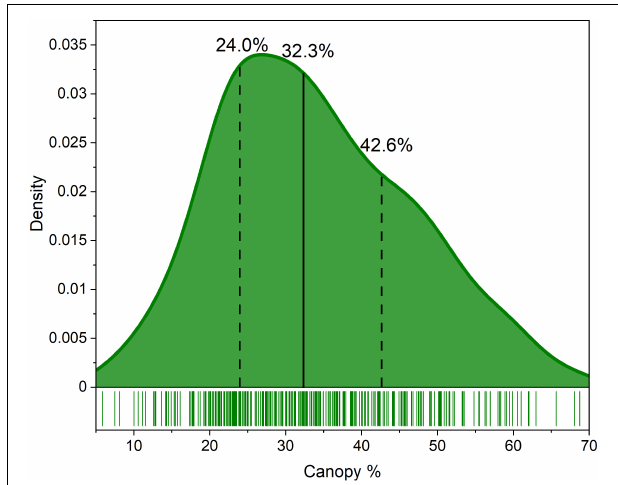
FIGURE 4 | Distribution of municipal percent urban tree canopy (UTC). The vertical solid black line represents the median UTC value. The two dashed lines represent the 25th percentile (left) and 75th percentile (right).